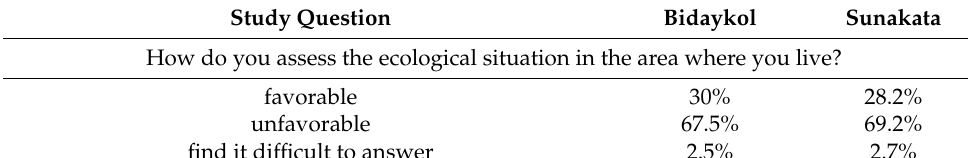
Table 3. The results of the survey on the ecological situation in the